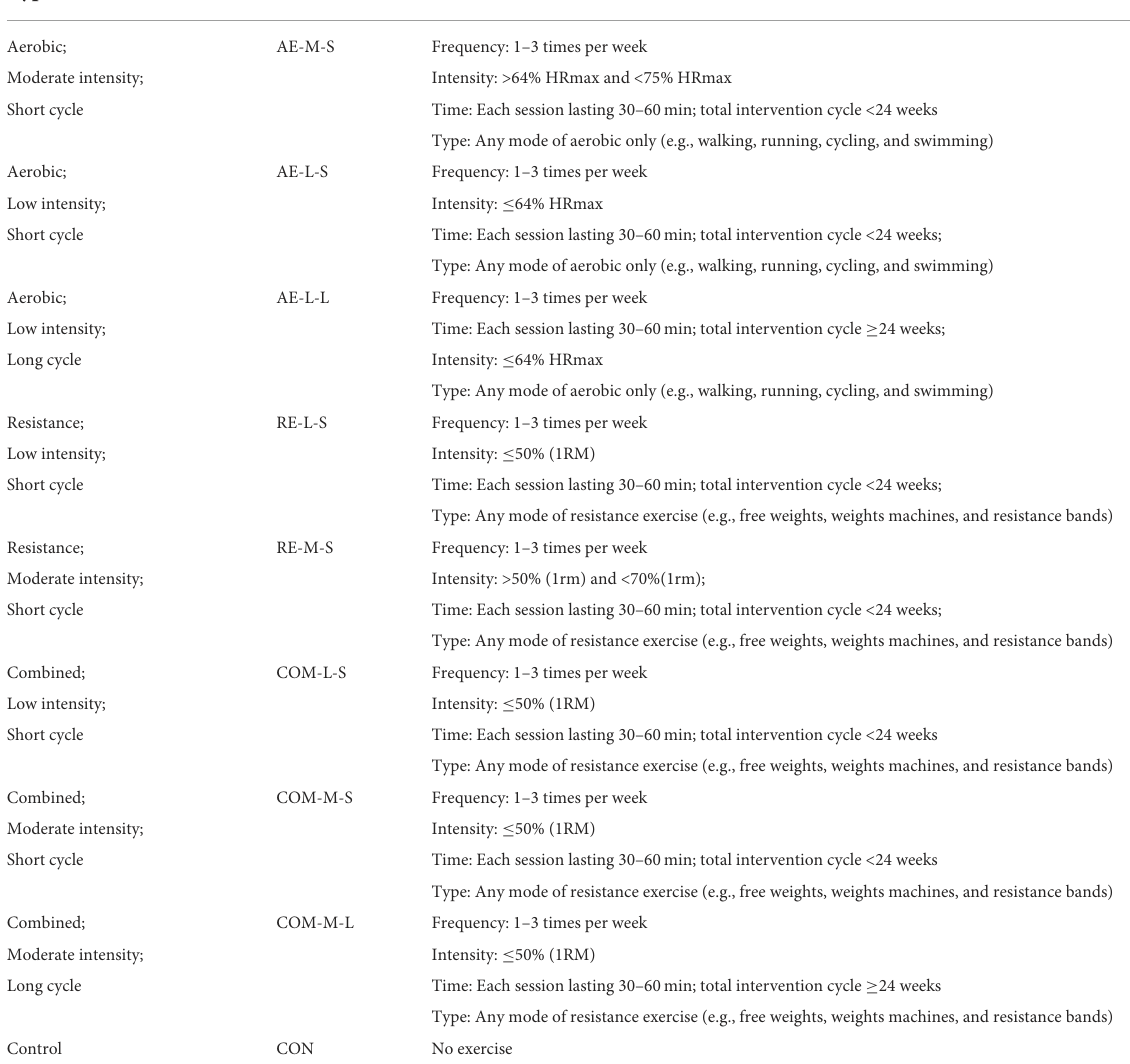
TABLE 1 Definition of the exercise interventions using the F.I.T.T.